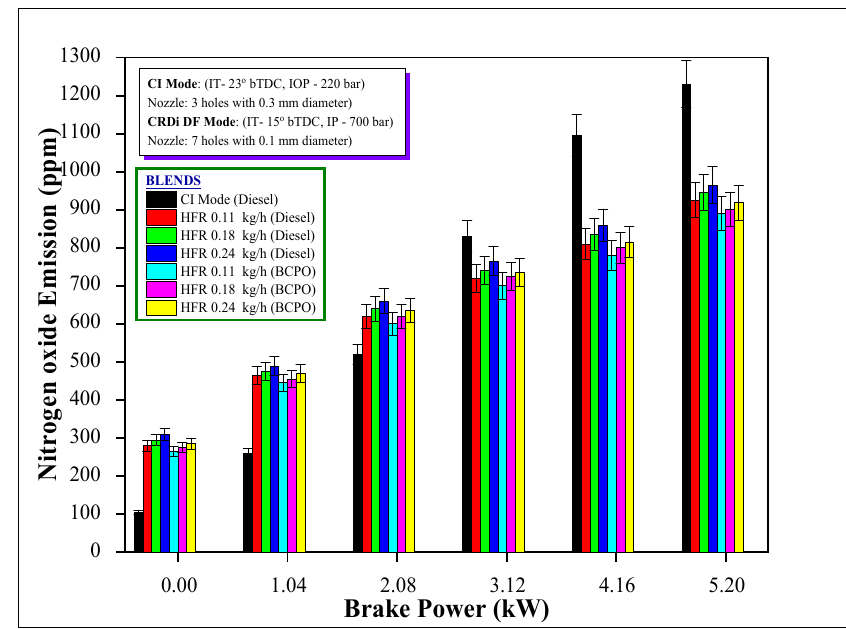
Figure 8. HFR and BP influence on CRDi engine NOx emission.